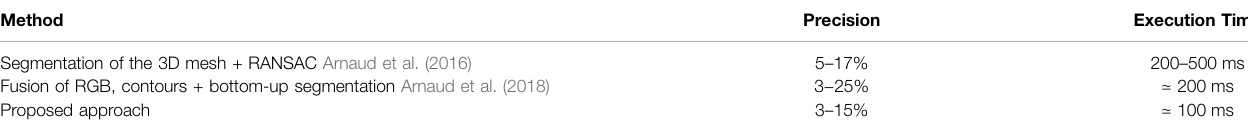
TABLE 3 | Synthetic comparison of three different methods. The precision is given as a percentage w.r.t the real dimensions. Method